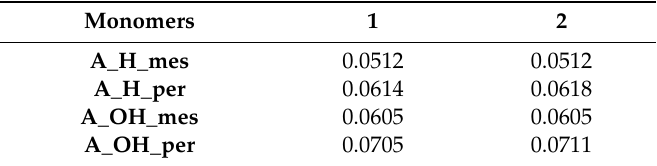
Molecules 2019 , 24 , x; doi: www.mdpi.com/journal/molecules